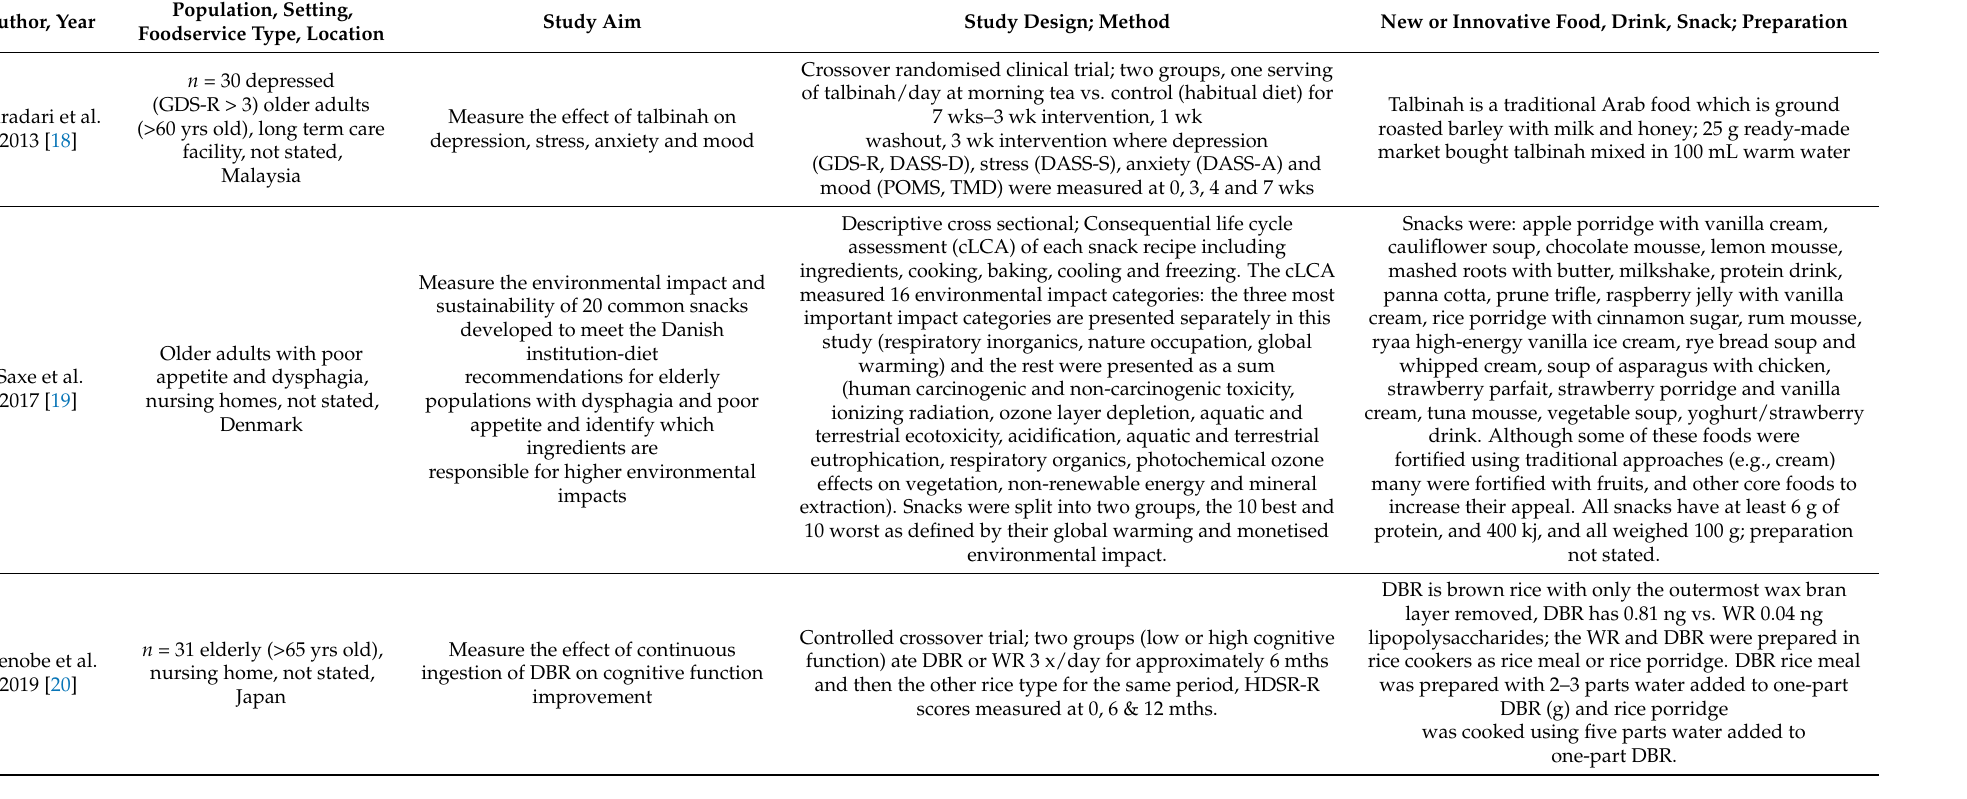
Table 2. Study characteristics of innovative food and drinks implemented in health and aged